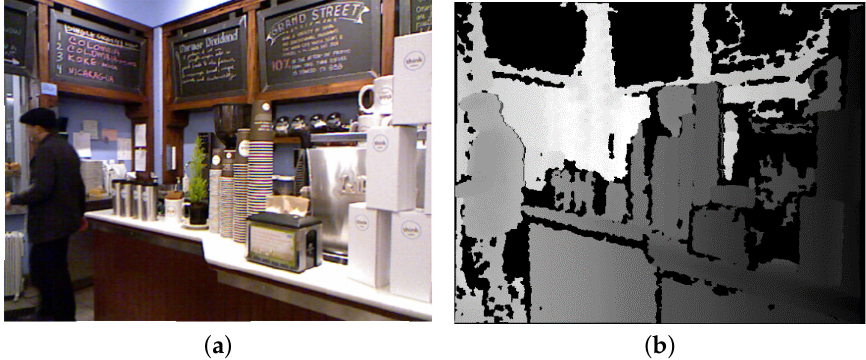
Figure 13. NYU Depth Dataset V2. ( a ) shows the colour image, and ( b ) shows the depth image.